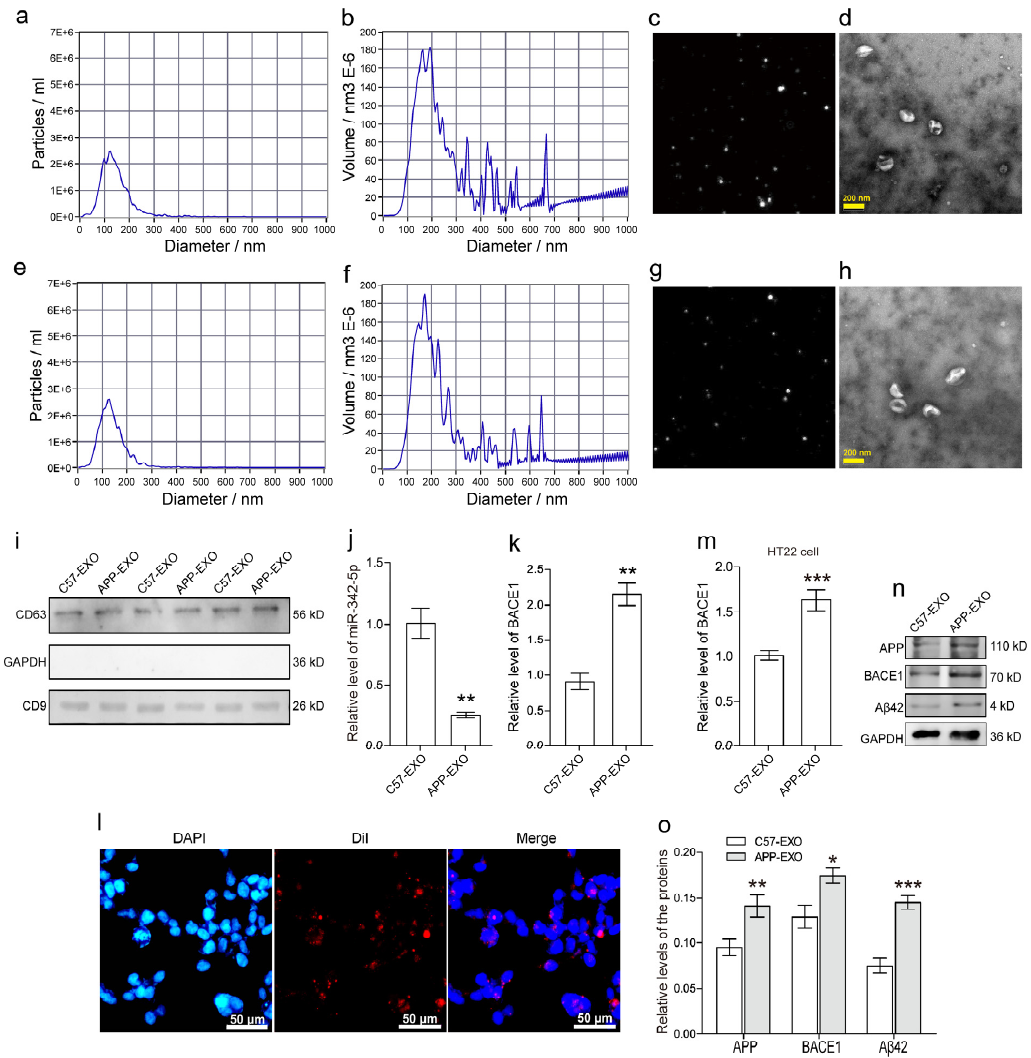
Figure 3. SEVs from APP transgenic mice distinctly promoted A β formation in mouse hippocampal HT-22 cells. SEVs were purified from APP mice ( a – d ) and C57BL/6 control mice ( e – h ). The sEVs were subjected to nanoparticle tracking analysis with a ZetaView instrument utilizing the properties of light scattering and Brownian motion to evaluate the exosome size distribution. In ( a,e ), the horizontal axis shows the particle diameters (nm) in the samples, and the vertical axis displays the concentrations (particles/mL) at a certain size. In ( b , f ), the horizontal axis shows the particle diameters (nm), and the vertical axis displays the particle volumes (×10 6 nm 3 ) at a certain diameter size. In ( c , g ), NTA video visualized light scattering sEVs, revealing the presence of vesicles of different sizes. In ( d , h ), the morphology of sEVs was visualized by transmission electron microscope (TEM). The scale bar is 200 nm. In ( i ), exosome markers CD9 and CD63 were detected by Western blot assay. GAPDH was used as a negative control. In ( j ), the RT-PCR assay quantified the relative levels of miR-342-5p in sEVs from APP and C57BL/6 mice. **, p < 0.01. In ( k ), RT-PCR quantified the relative levels of BACE1 in APP and C57BL/6 sEVs. **, p < 0.01. In ( l ), a Nikon fluorescent microscopy was used to visualize the internalization of Dil-labeled sEVs into HT22 cells. Cell nuclei were detected with the fluorescent dye DAPI. Scale bars represent 50 μ m. In ( m ), an RT-PCR was applied to detect the relative levels of BACE1 in HT22 cells incubated with the sEVs from APP and C57BL/6 mice, respectively. ***, p < 0.001. In ( n ), a Western blot assay was used to detect APP, BACE1, and A β 42 proteins in HT22 cells incubated with the sEVs from APP and C57BL/6 mice, respectively. The experiments were performed in triplicate. In ( o ), the intensities of the immunobands for APP, BACE1,